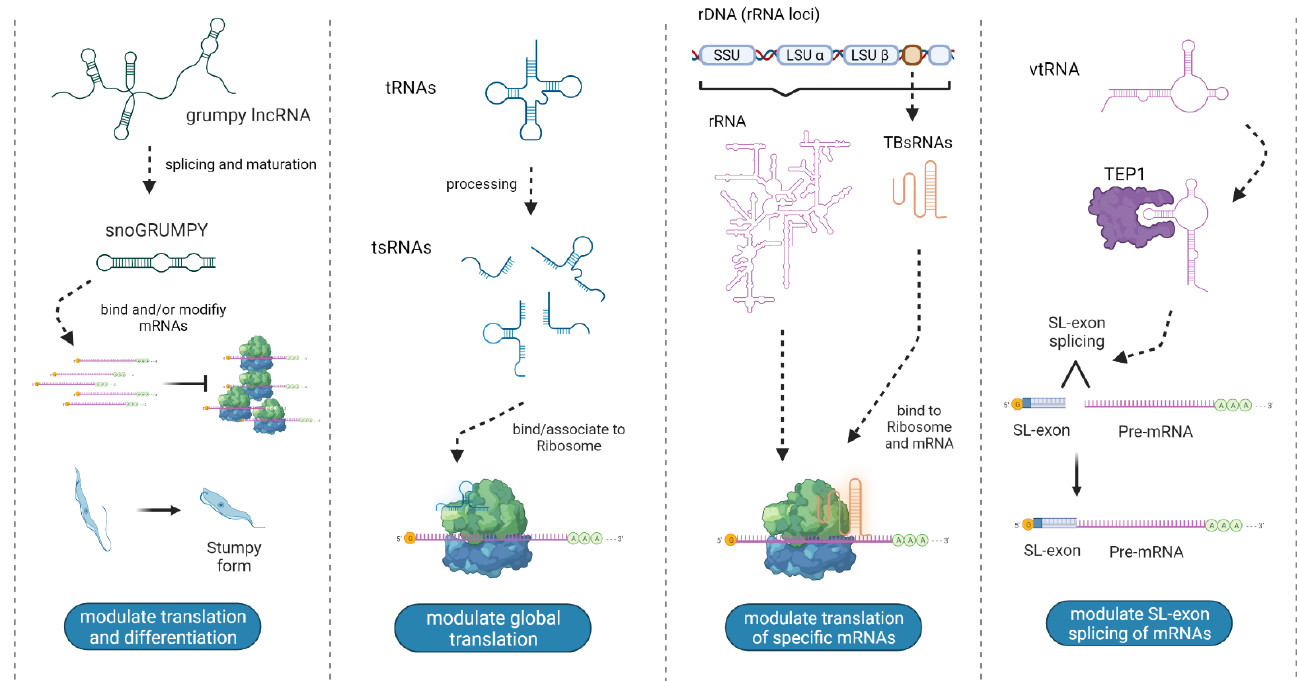
Figure 3. Regulatory non-canonical ncRNAs with experimentally demonstrated roles reported in trypanosomatids. The illustrations represent the structure, processing and proposed mechanisms of action of the four ncRNAs reported so far [28,30,37,57]. Created with BioRender.com (accessed on 13 May 2022).